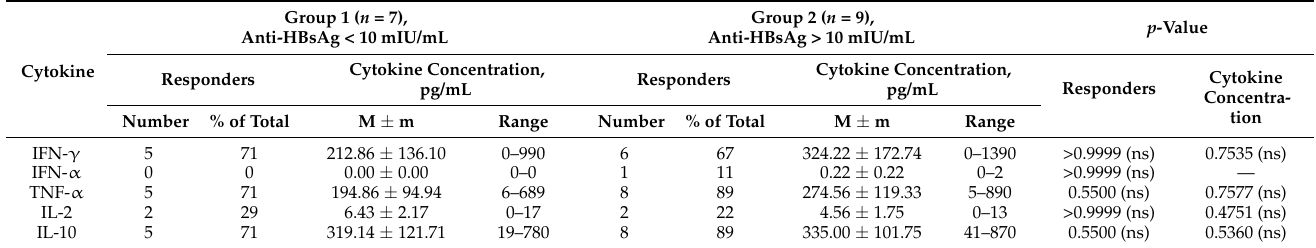
Table 5. Comparison of PBMC cytokine responses to stimulation with wild-type rHBsAg (ayw2) in donor groups with different levels of serum antibodies to HBsAg 1